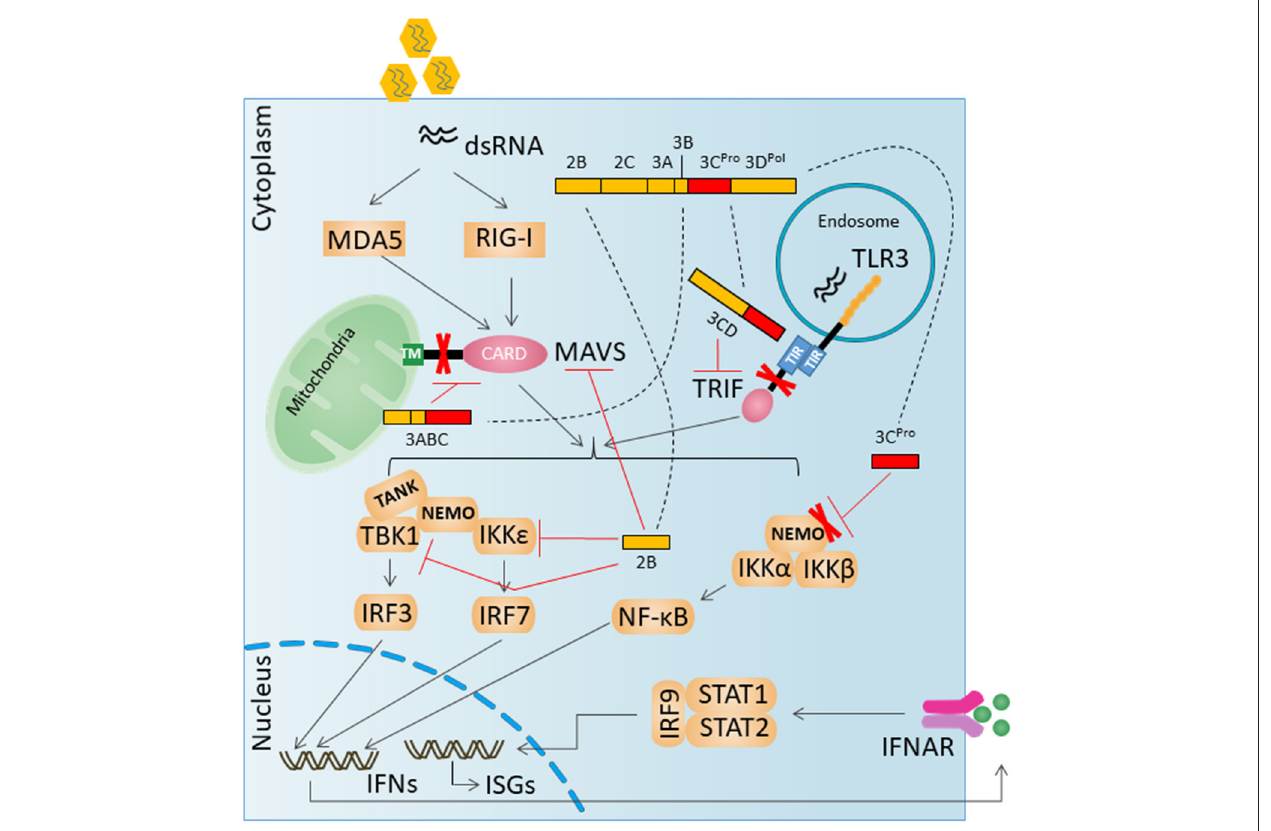
FIGURE 2 | HAV evades innate antiviral responses by degradation key innate immune signaling proteins. A virally encoded, catalytically active polyprotein processing intermediate, 3ABC, degrades MAVS. A second catalytically active 3C pro processing intermediate, 3CD, cleaves the TLR3 adaptor protein TRIF. 3C pro can mediate the degradation of